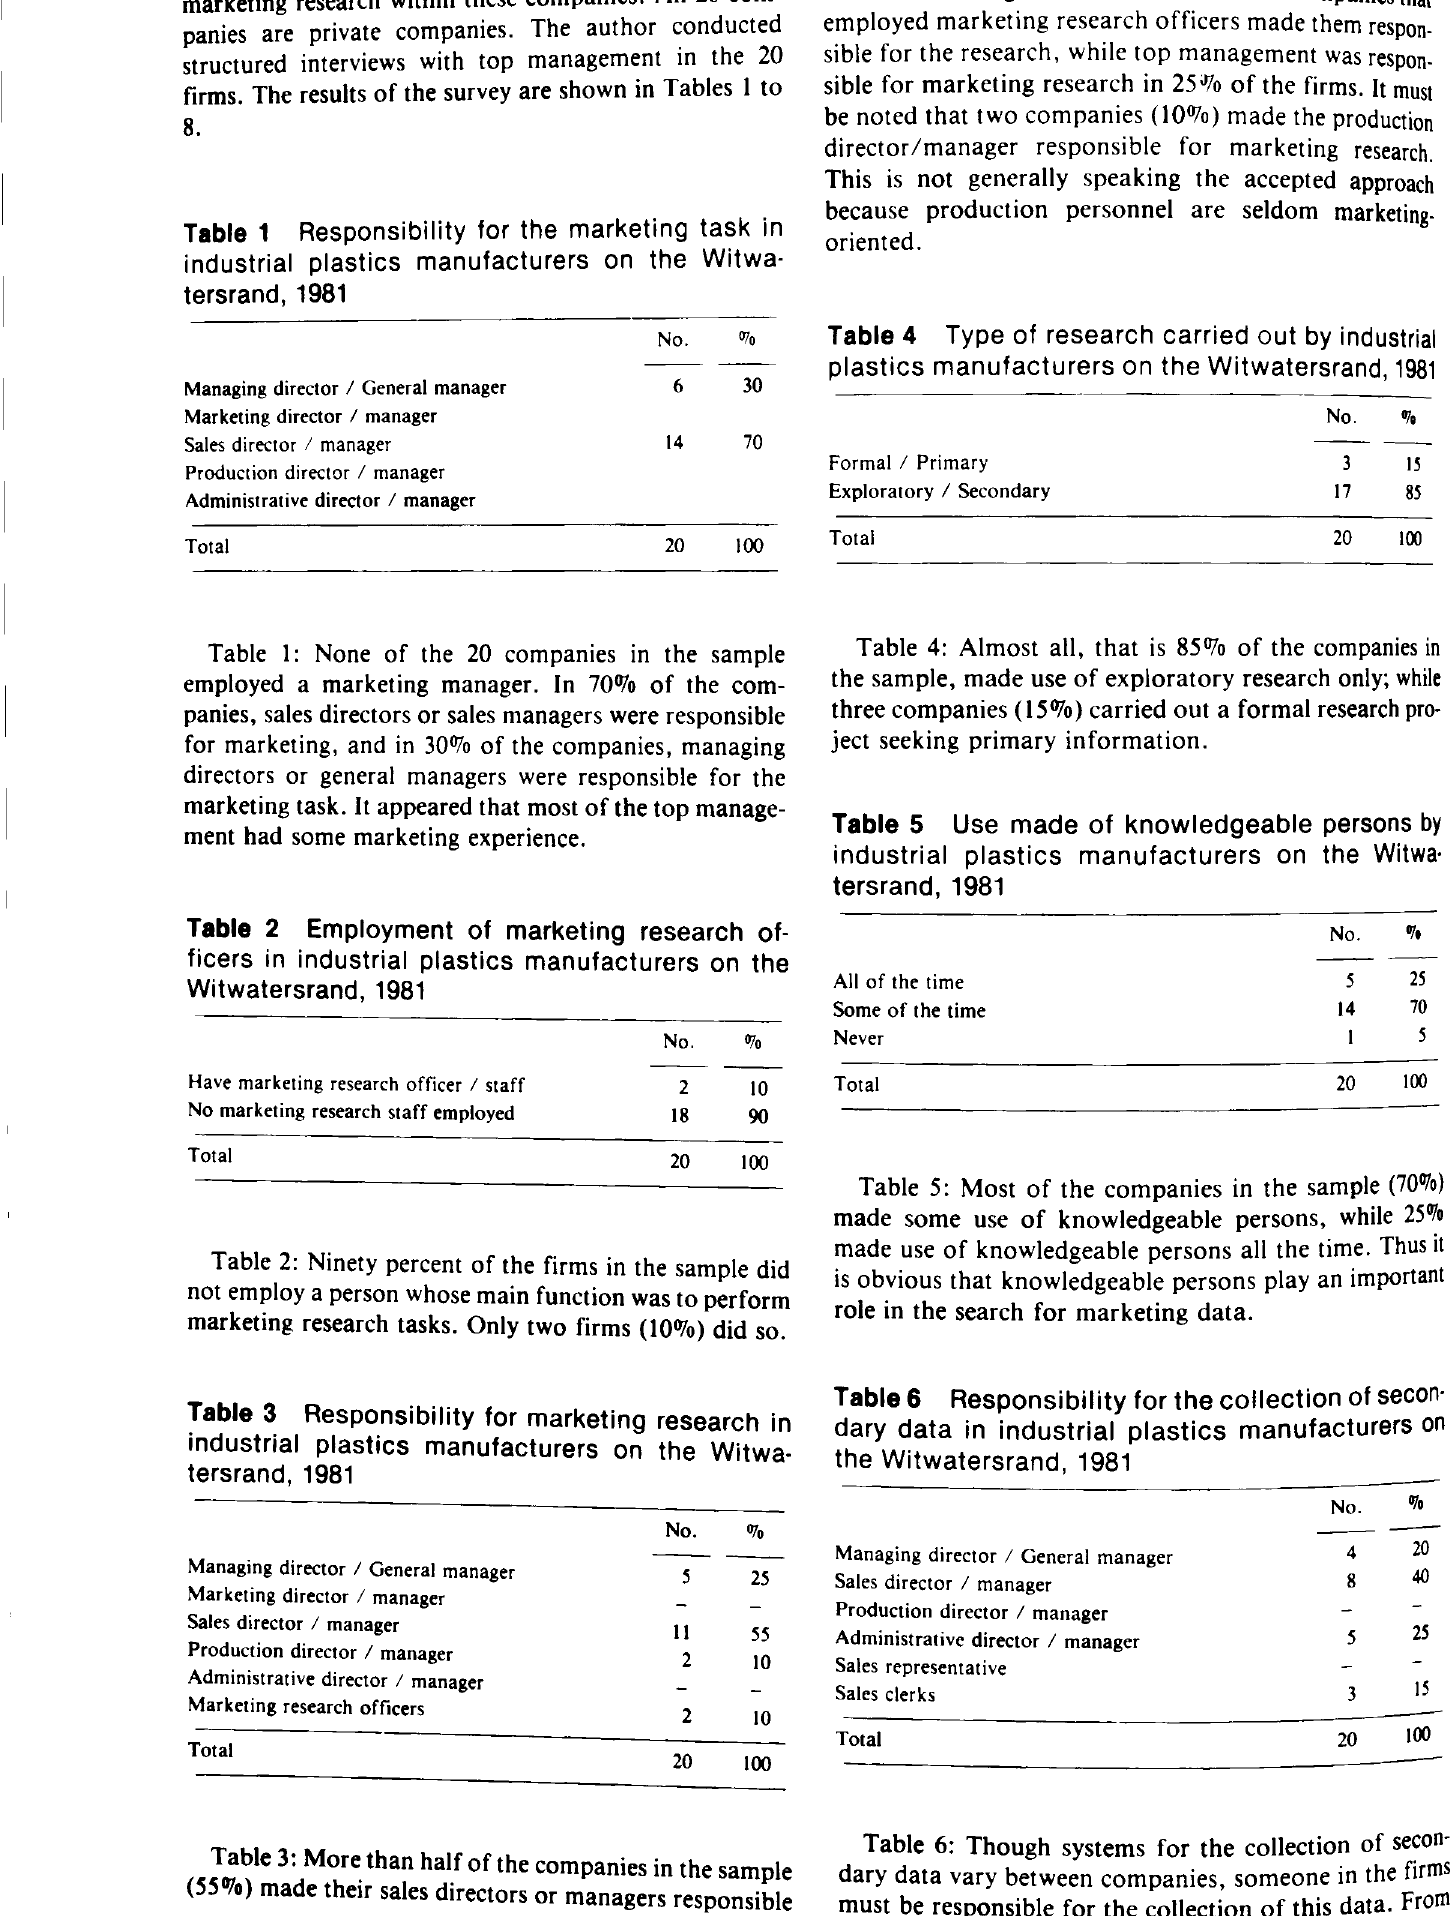
Table 3: More than half of the companies in the sample (550/t) made their sales directors or managers responsible